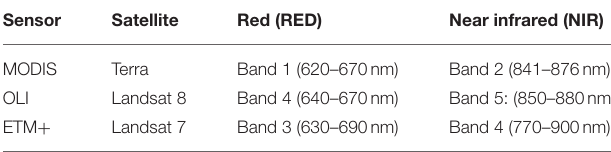
TABLE 2 | Satellite sensor spectral bands used in the calculation of